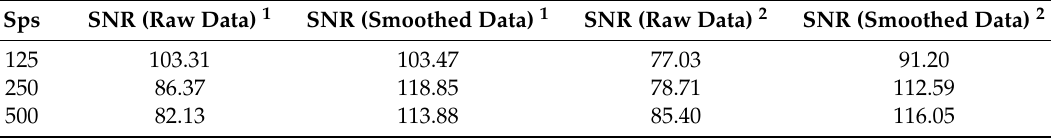
Figure 15. Synthetic data acquired from a patient simulator at different sampling rates. Table 3. SNR (signal-to-noise ratio) measurement in the synthetic data.